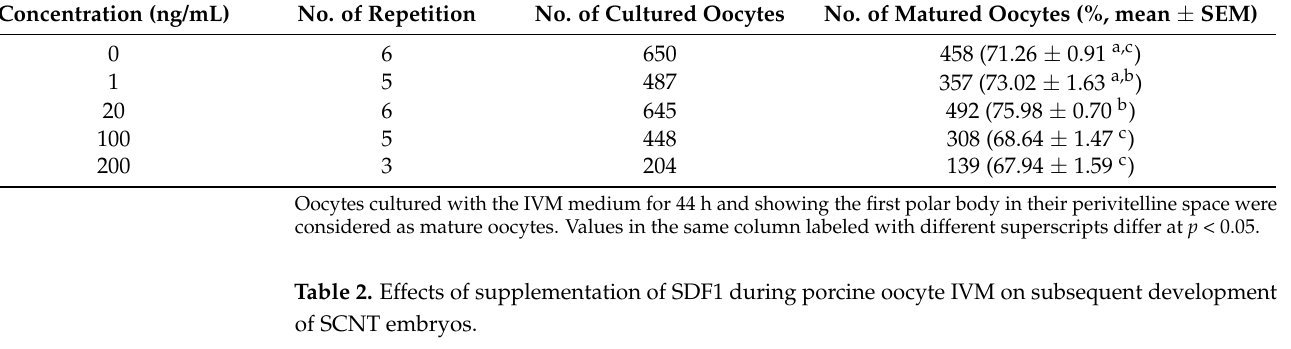
Table 1. Effects of supplementation of SDF1 during IVM on maturation rate of pig oocytes.